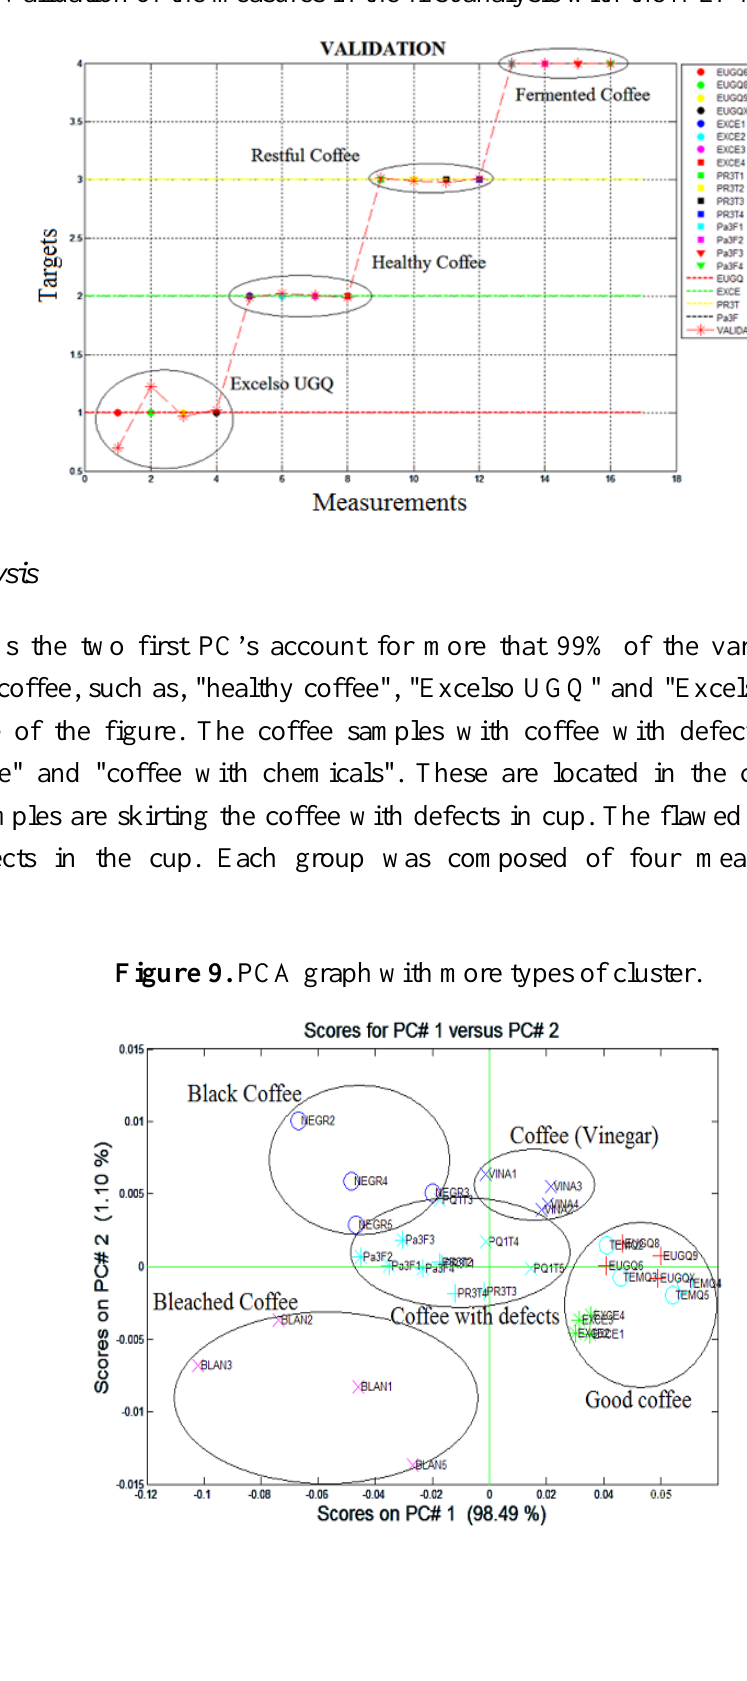
Figure 8. Validation of the measures in the first analysis with the MLP Neural network.